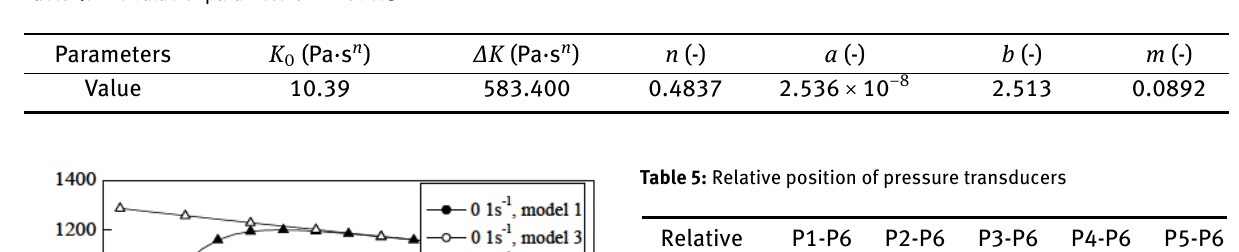
Table 4: The value of parameters in Model 3